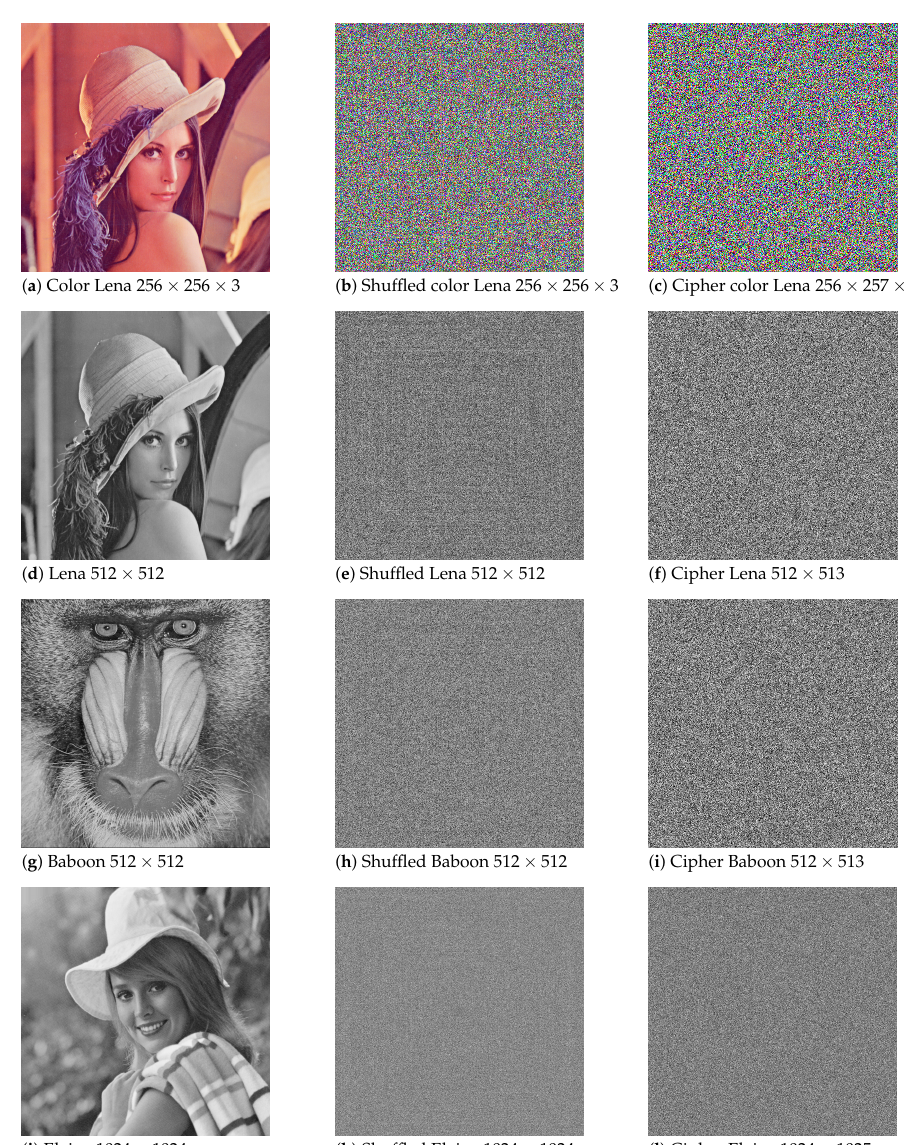
Figure 5. Test images of different sizes and their corresponding shuffled and cipher images.